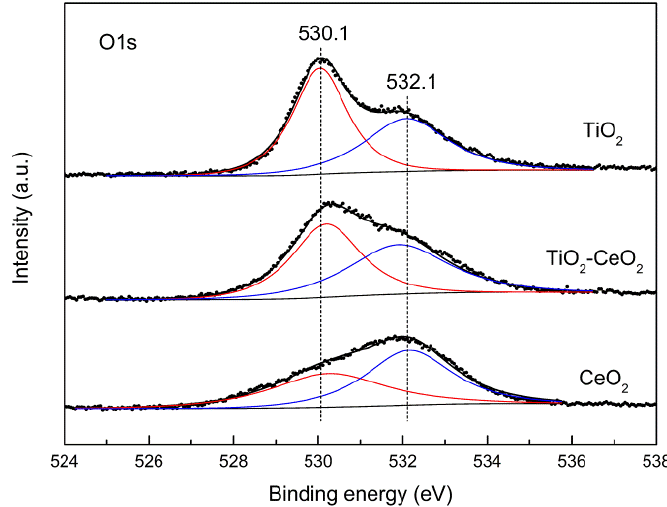
Figure 6. XPS (O 1s) spectra of the CeO 2 , TiO 2 and TiO 2 -CeO 2 catalysts.